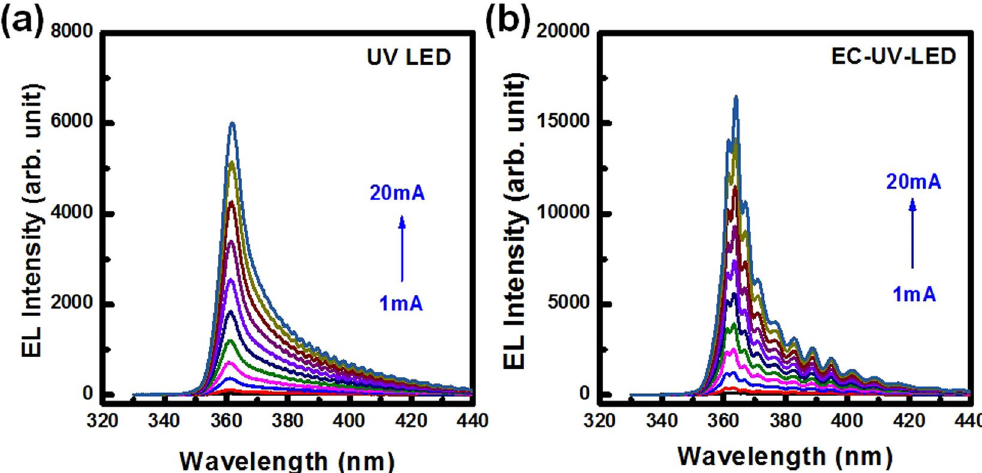
Figure 5. The EL emission spectra of the ( a ) UV-LED and ( b ) EC-UV-LED were measured by varying the injection current at room temperature.